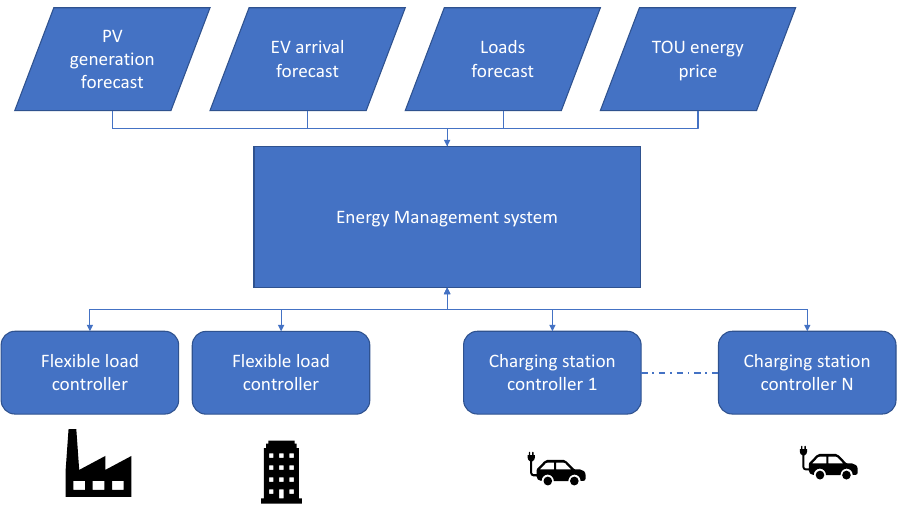
Figure 5. Structure of the Energy Management